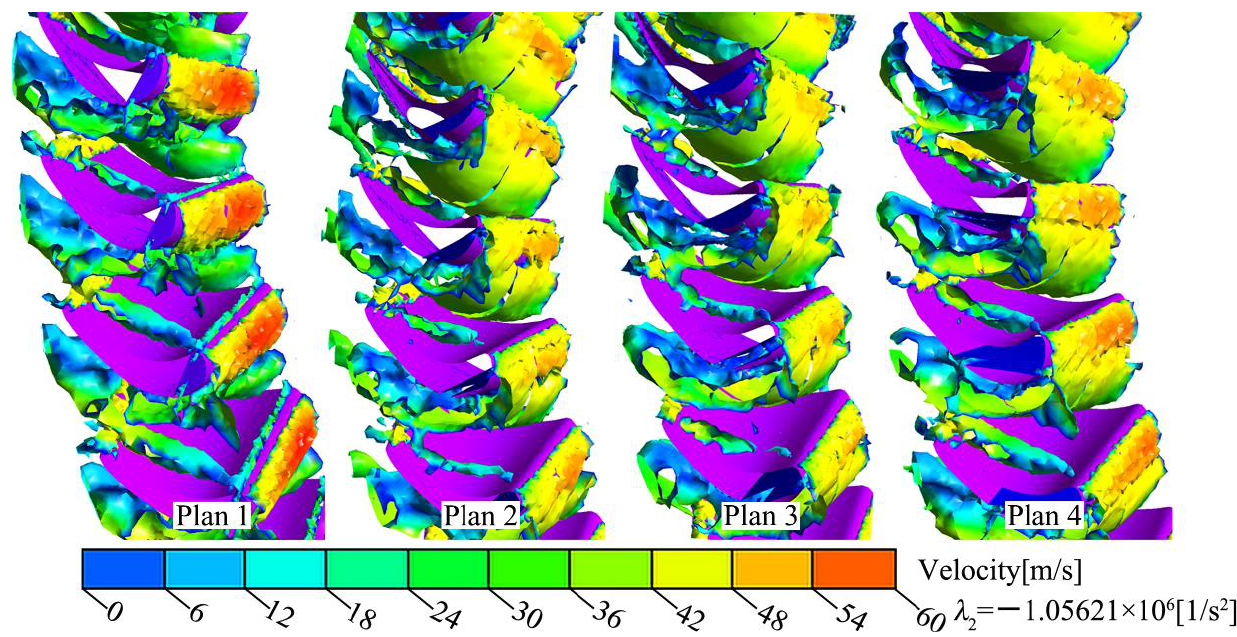
Figure 10. Iso-surfaces of the λ 2 criterion near the stator blade with different suppression slots ( t = 0.12s, SR = 0).